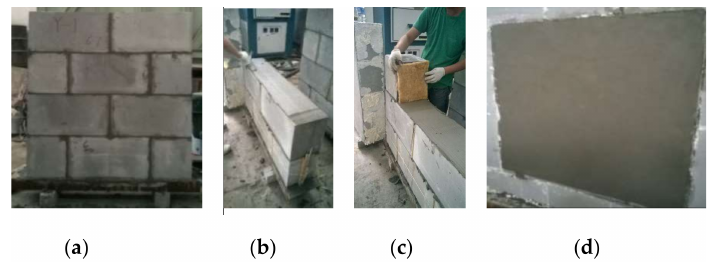
Figure 2. Construction of masonry specimens: ( a ) finished specimens; ( b ) flatting horizontal mortar joint; ( c ) rock wool for vertical joint; ( d ) finished specimens with plastering surface.